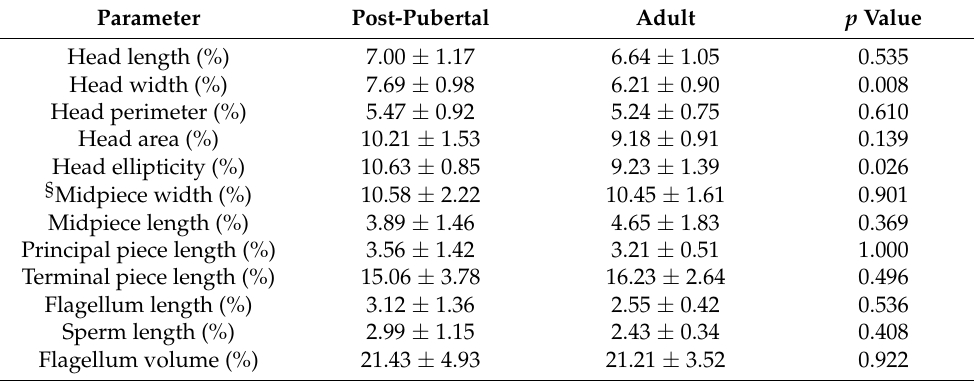
Table 6. Intra-male coefficient of variation of epididymal sperm morphometry in <1-year-old (post- pubertal, n = 9) and >1-year-old (adult, n = 7) sexually mature